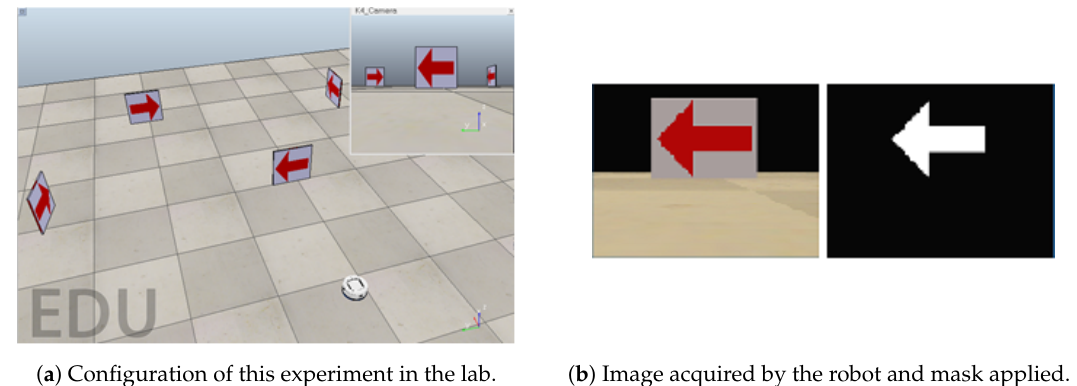
Figure 7. Detection of arrows of the same color in a simulated